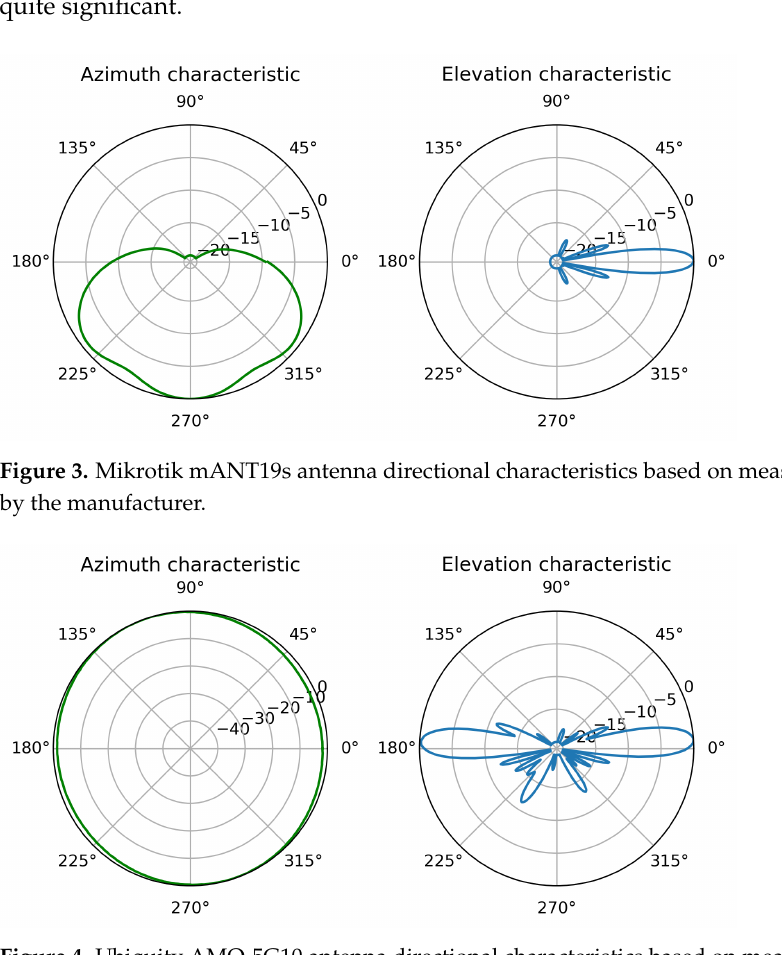
Figure 4. Ubiquity AMO-5G10 antenna directional characteristics based on measurements provided by the